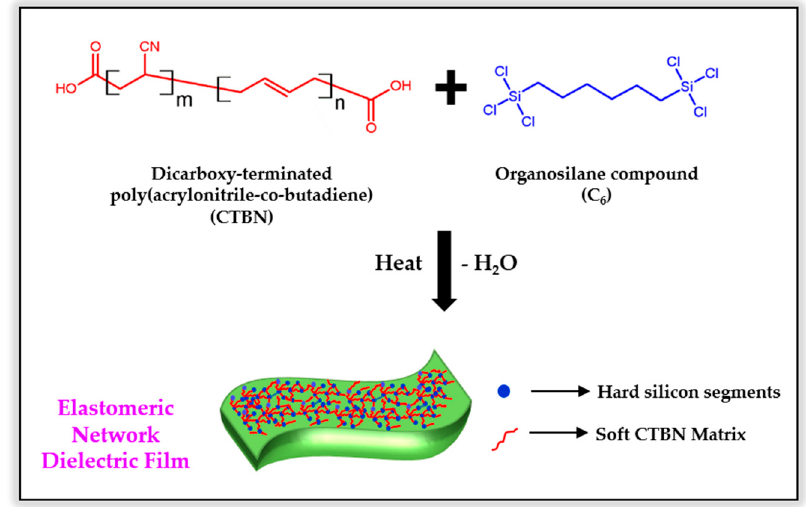
Figure 2. Schematic representation of the elastomeric network dielectric film formation using CTBN and C 6 . Adapted with permission from [75], American Chemical Society, 2018.